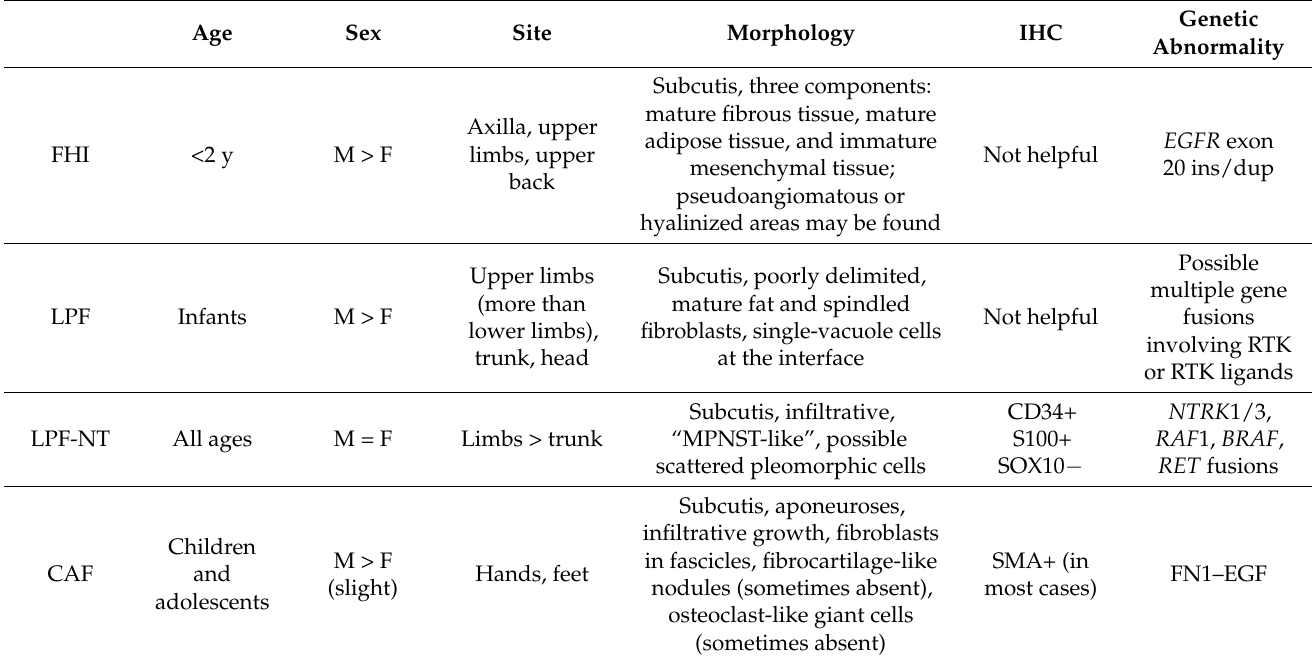
Table 2. The main clinical and pathological features of “LPF-like”